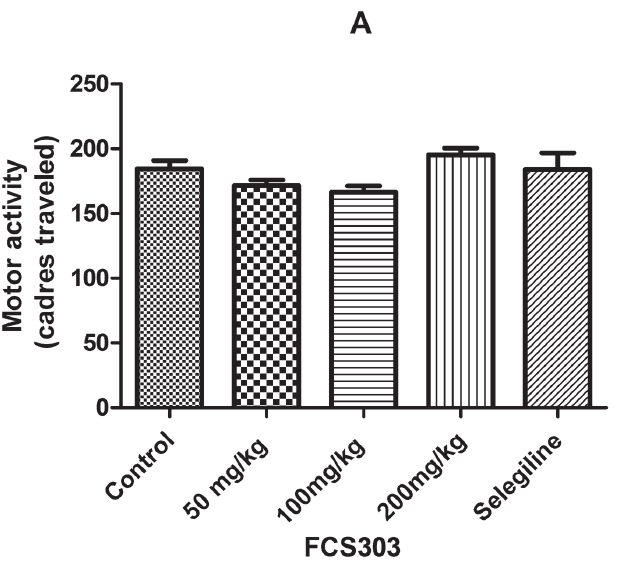
FIGURE 2A - Effect of administration of FCS303 (50, 100, and 200 mg/kg), control (vehicle 0.1 mL/10 g body weight), or selegiline (10 mg/kg) on motor activity in non-reserpinized mice. The animals were observed in an open-field test at 1.5 h after administration of compound FCS303. n = 7–9. *p < 0.05 compared to the control group.